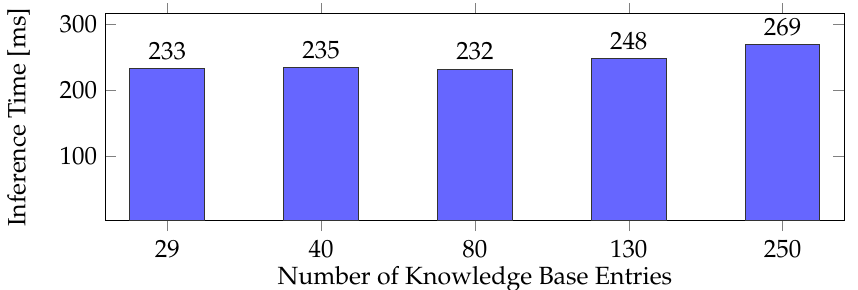
Figure 18. Inference time for different knowledge base